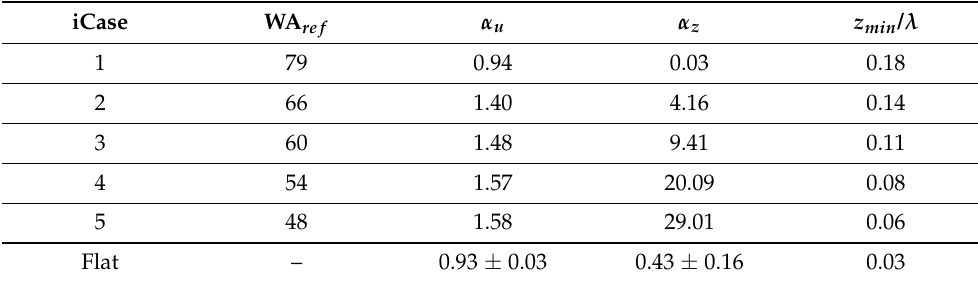
Table 2. Log law-fit of Equation (15) to the outer surface layer: Optimal [ α u , α z ] , for RMS dif f <